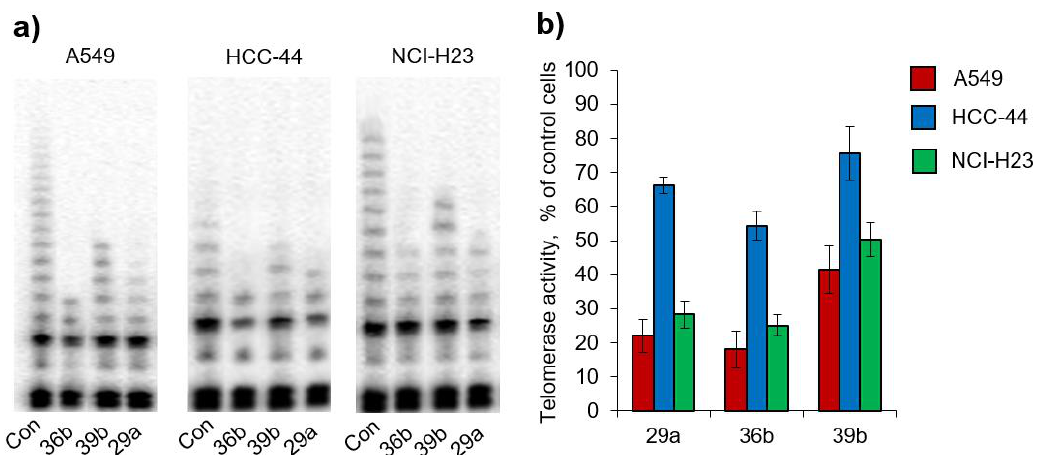
Figure 6. Compounds 29a , 36b , and 39b suppress the activity of telomerase. ( a ) Electrophoresis of A549, HCC-44, or NCI-H23 cells treated for 48 h with 10 µ M compounds 29a , 36b , and 39b on a TRAP gel. ( b ) For live cells, TRAP quantification. The mean ± SEM is used to display the results. Con, control intact cells.